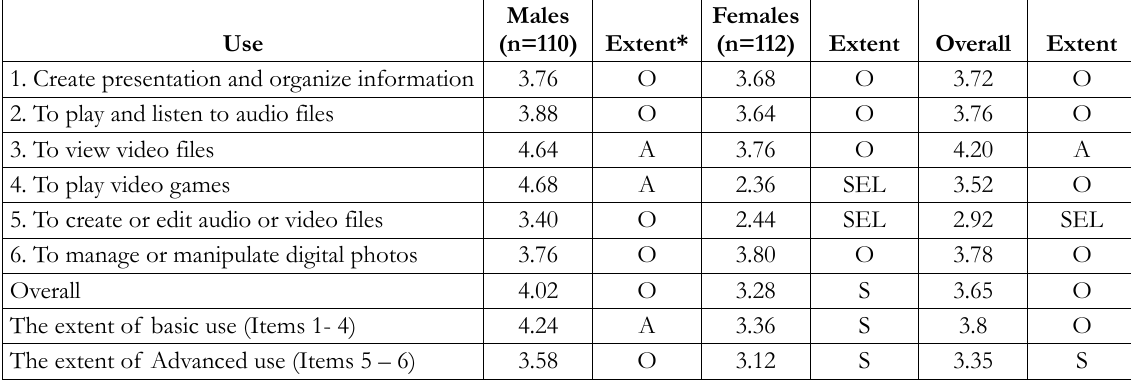
Table 3. The extent of use of a mobile device (N=222)